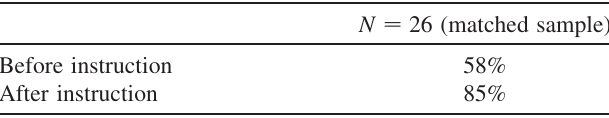
TABLE III. Correct responses on content: Performance com- parison of graduate students in displaying appropriate content knowledge on electric circuits as a result of instruction in the graduate course. (See Fig. 1 for before instruction and Fig. 2 for after instruction questions.)